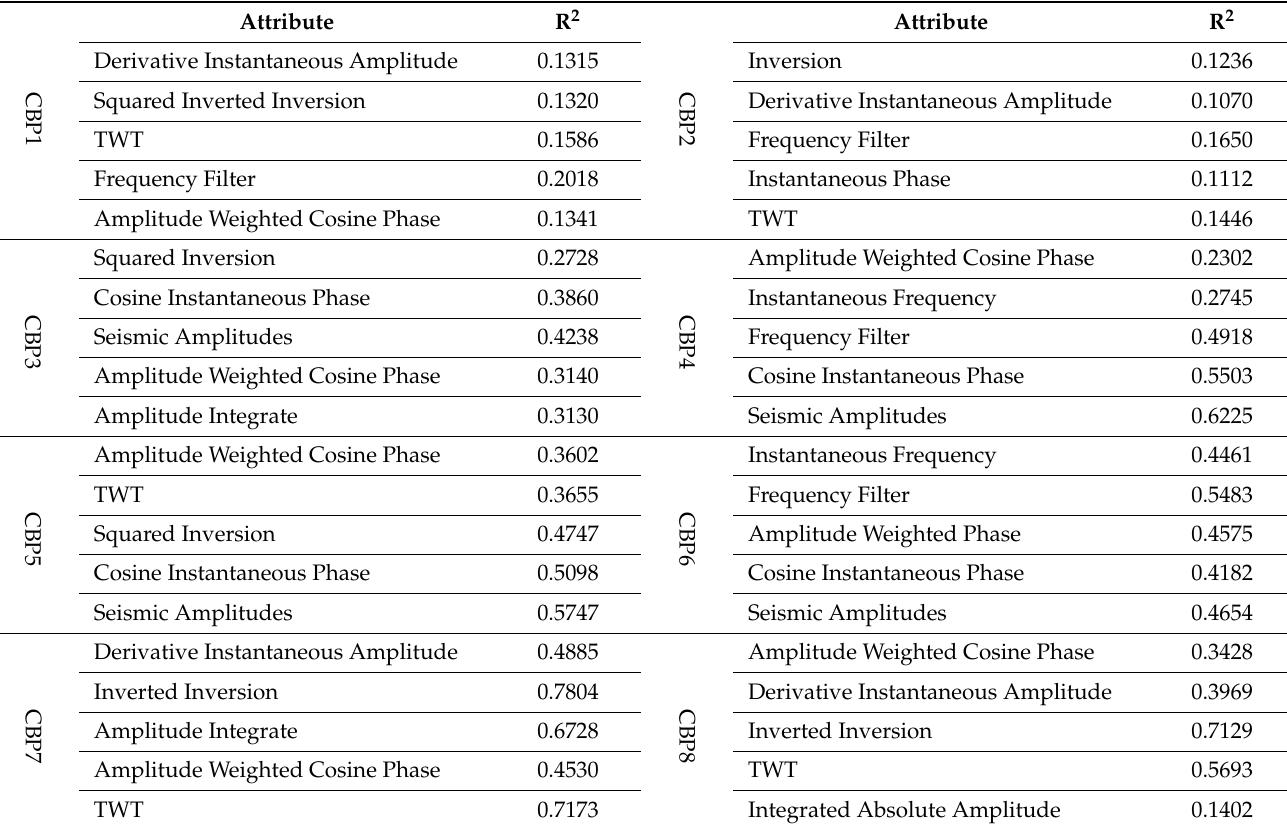
Figure 8. Two-dimensional (2D) seismic section passing through the employed well ( a ); and its four corresponding seismic attributes, including cosine of phase ( b ), instantaneous frequency ( c ), apparent polarity ( d ), and amplitude envelope ( e ). Table 3. Linear relationships of the seismic attributes (inputs) and CBPs (outputs)